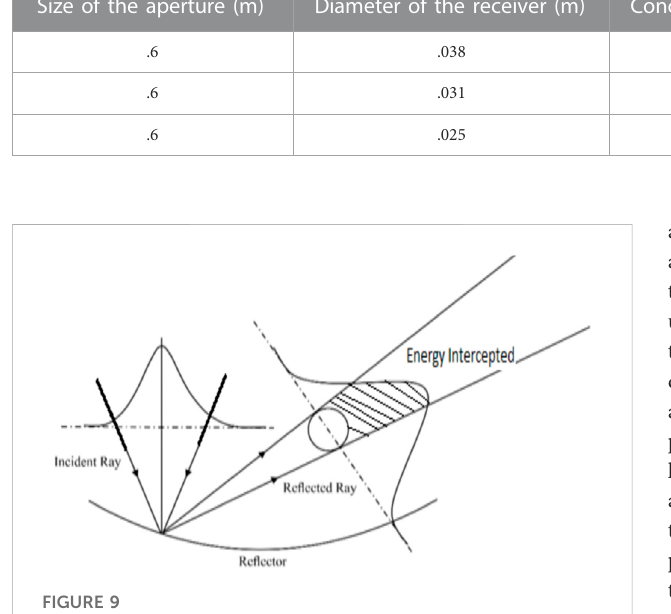
Incident beam re fl ection and distribution over the receiver (Caron and Roger, 2015).